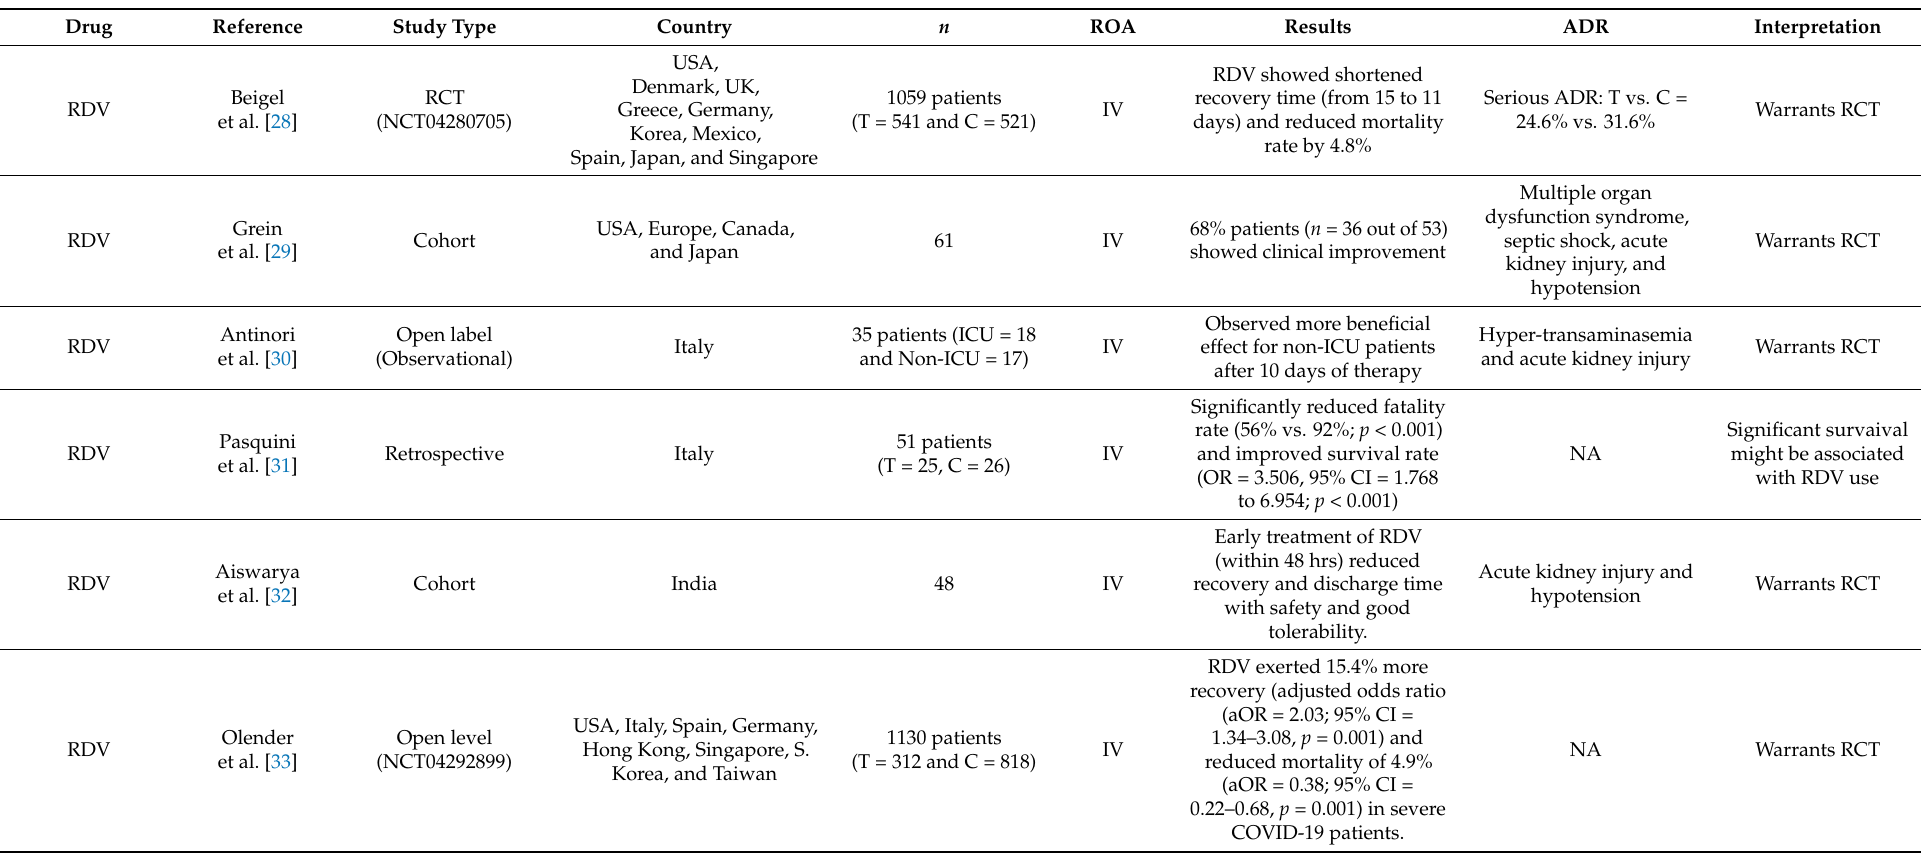
Table 1. Summary of the latest clinical trials and observational studies to investigate the safety and efficacy several repurposed antiviral drugs against